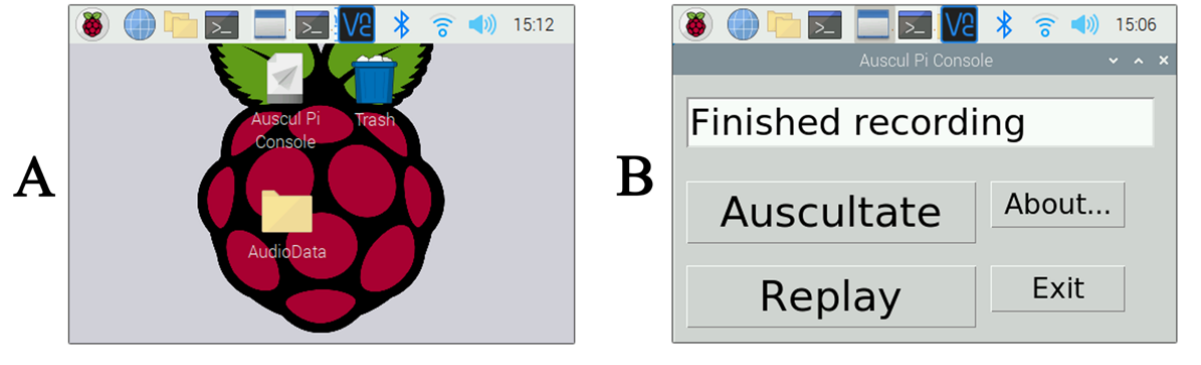
Figure 6. The graphical user interface on the touch screen of Auscul Pi. (A) The desktop display. The user can double-tap the Auscul Pi icon to run the program. The recorded data are stored in the AudioData folder. (B) The manipulation interface of the Auscul Pi Console after double-tapping the Auscul Pi Console icon. The user can control the auscultation and replay by tapping the “Auscultate” and “Replay” buttons,